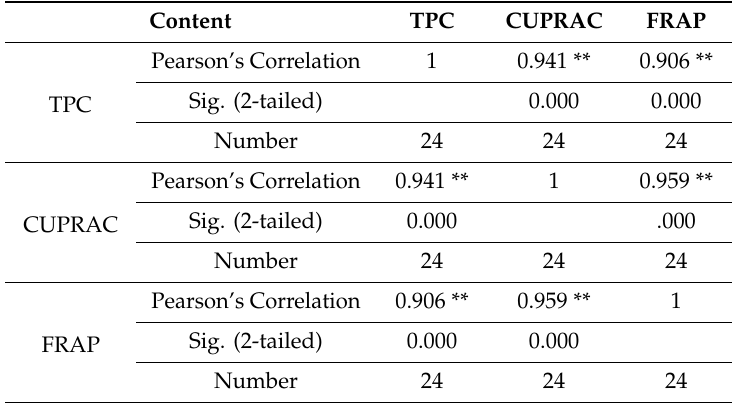
Table 3. Correlation between total phenolic content (TPC) and antioxidant activity (measured by CUPRAC and FRAP assays) of three tamarillo